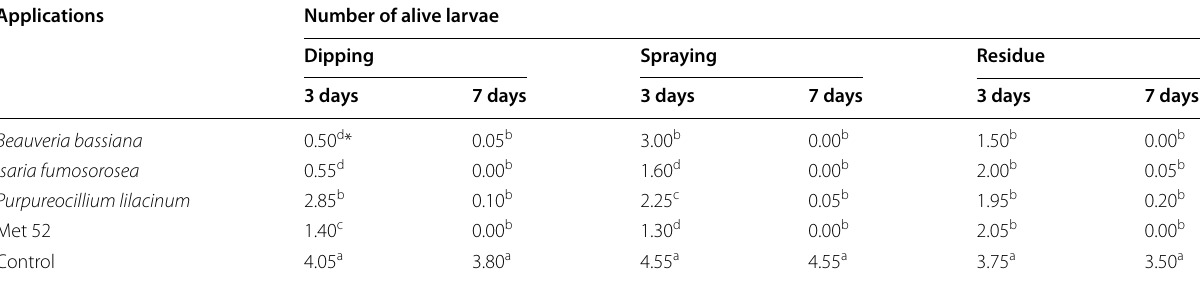
Table 2 Mean numbers of alive third instar Tuta absoluta larvae, 3 and 7 days after the applications of entomopathogenic fungi by three methods in petri dish trials